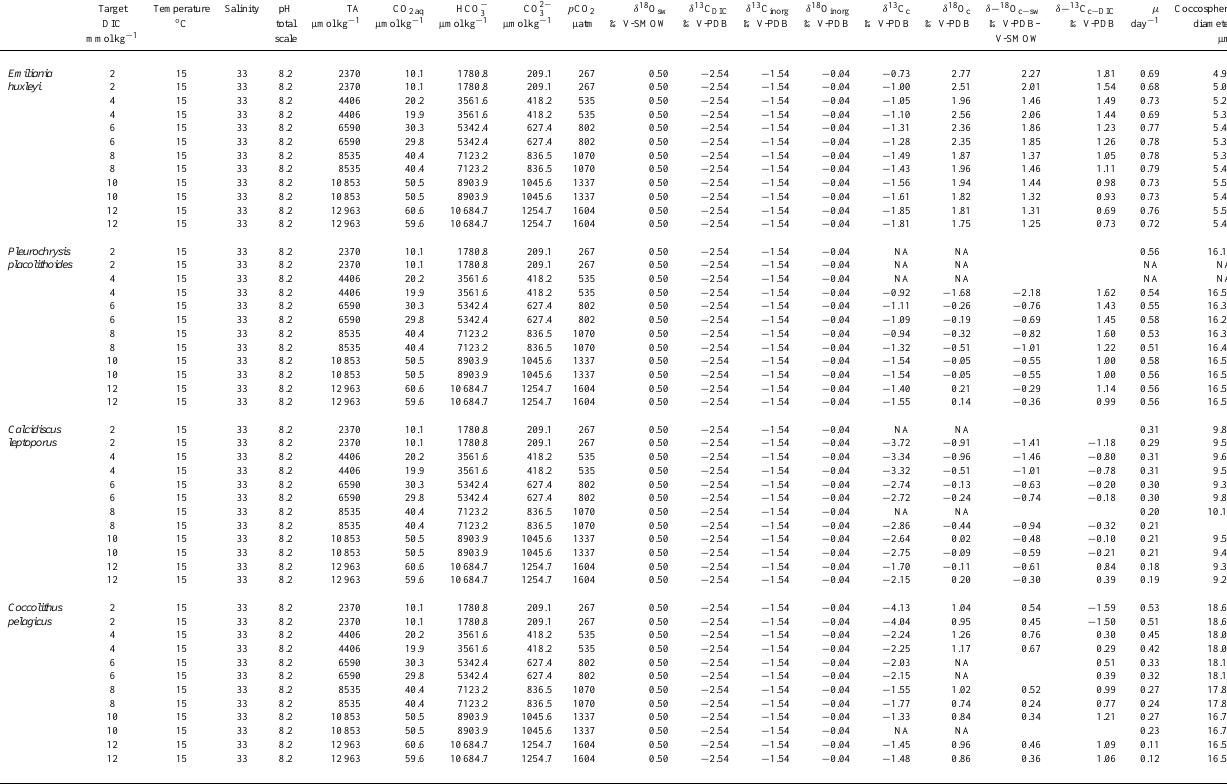
Table 1. Numerical data